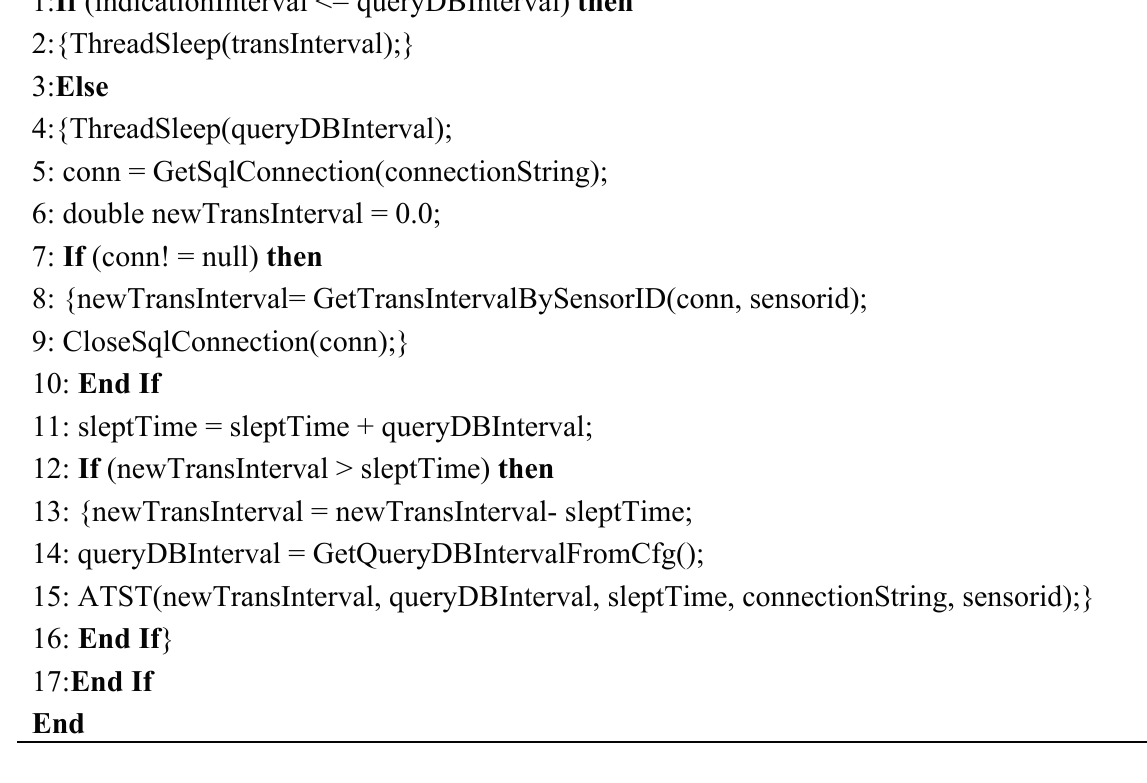
Table 3. Database table that stores sensor and sensor platform data collection